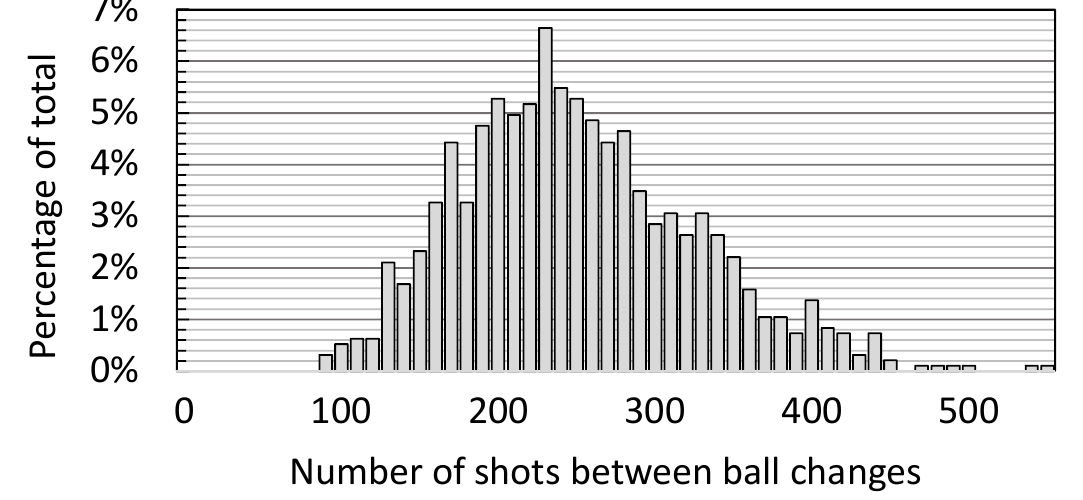
Figure 2. The distribution of racket impacts made between ball changes, 234 on average. The small number of very low